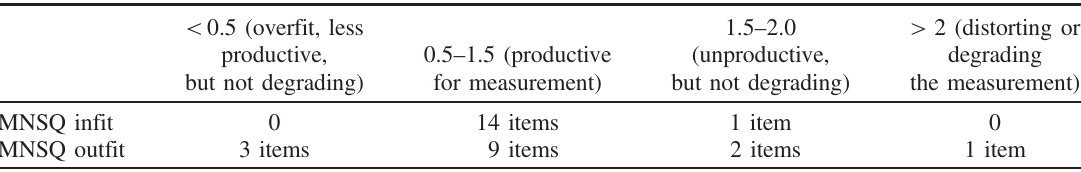
TABLE IV. The distribution of MNSQ infit and outfit statistics for our test items; the provided interpretation guidelines are recommended by Wright and Linacre